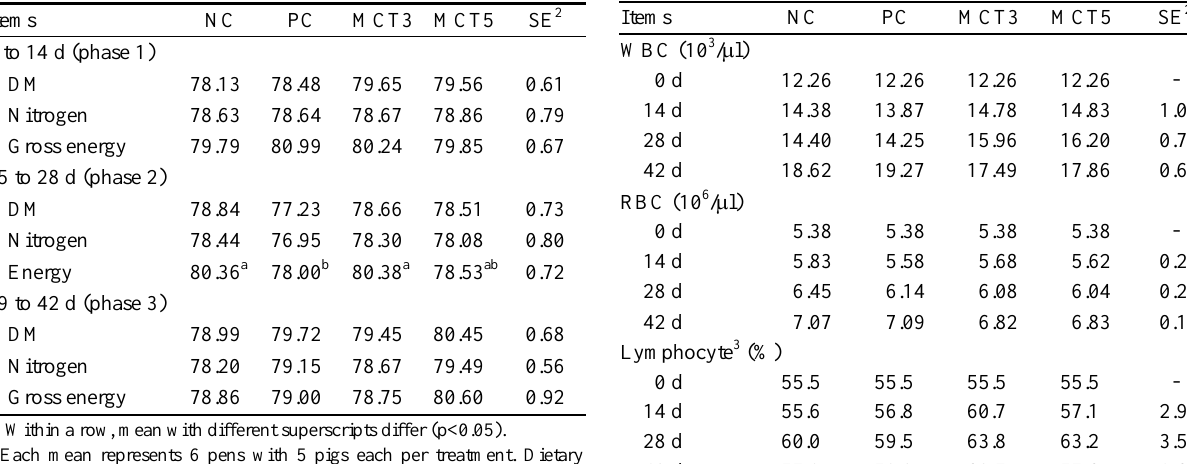
Table 4. Effect of medium-chain-triglyceride on blood characteristics of weanling pigs at d 42 (Exp. 1) 1